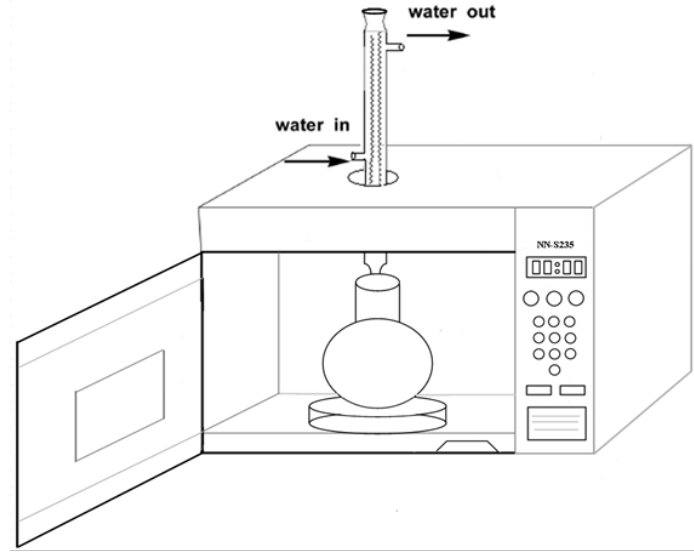
Figure 8. Experimental arrangement.